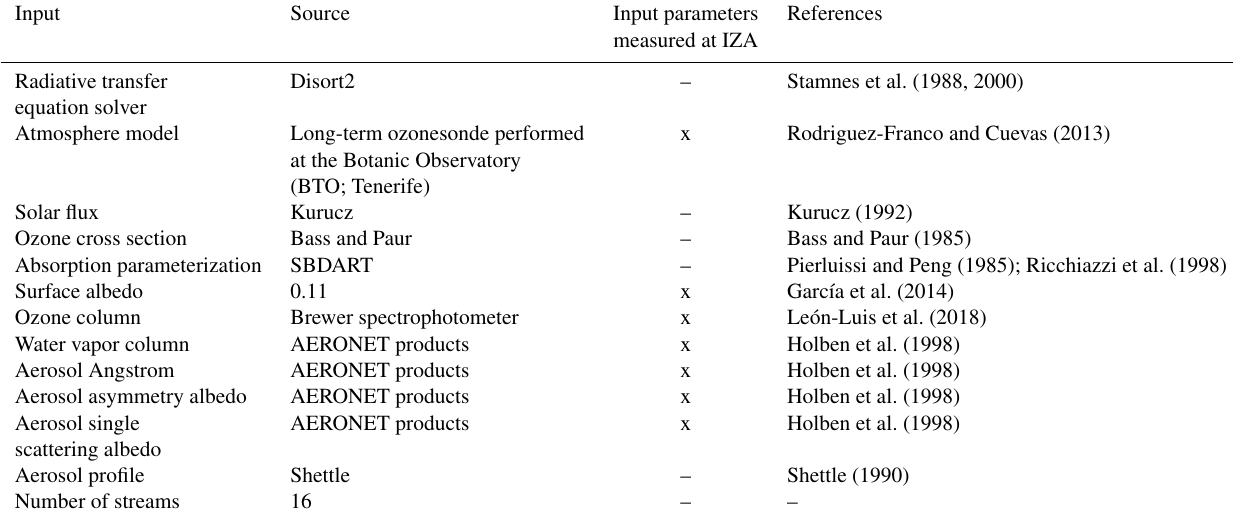
Table 6. The input parameters of the LibRadtran model, their sources and corresponding